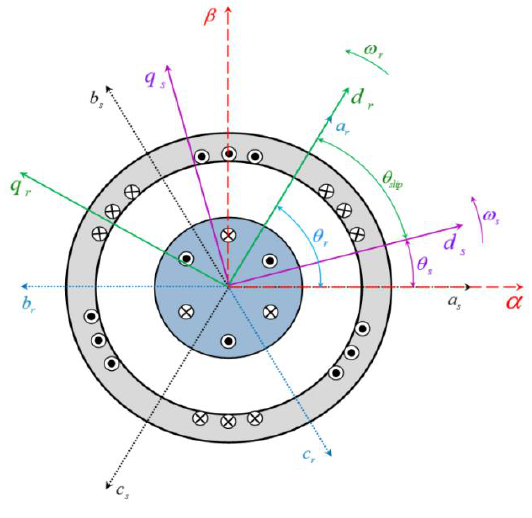
Figure 2. DFIG reference frames.